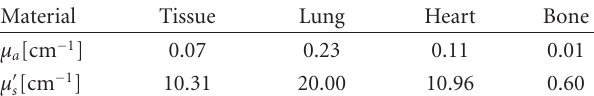
Table 1: Optical properties of di ff erent